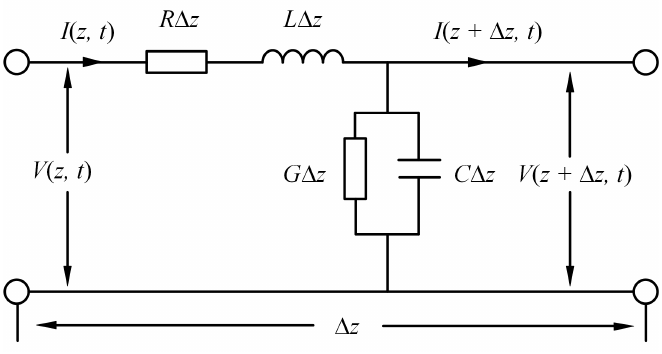
Figure 3. ∆ z -length transmission line.